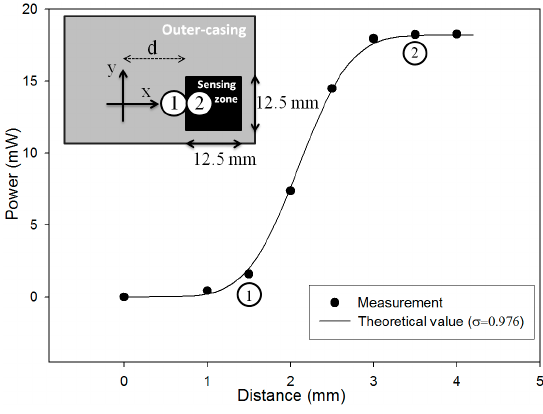
Figure 3. Light parallel shifts corresponding to light intensity variations.